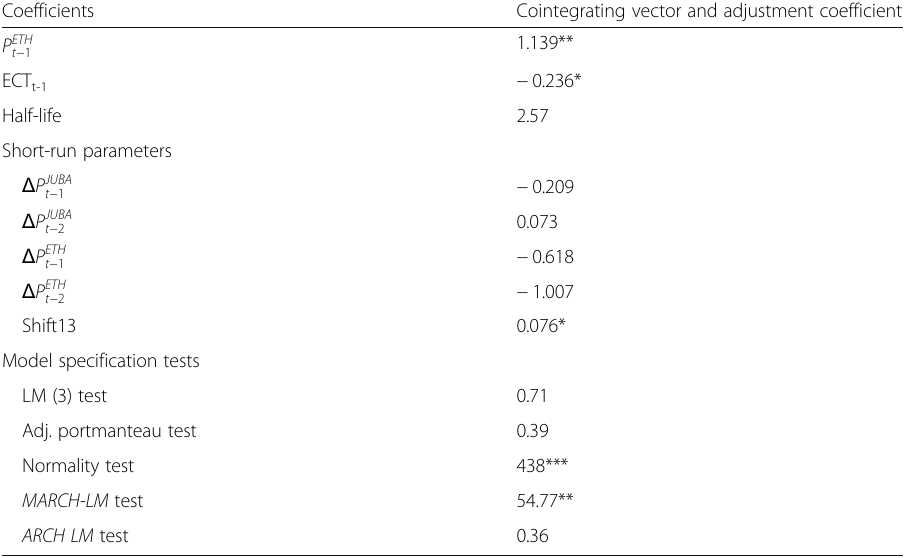
Table 10 Vector error correction model results for Juba and Addis Ababa market pairs